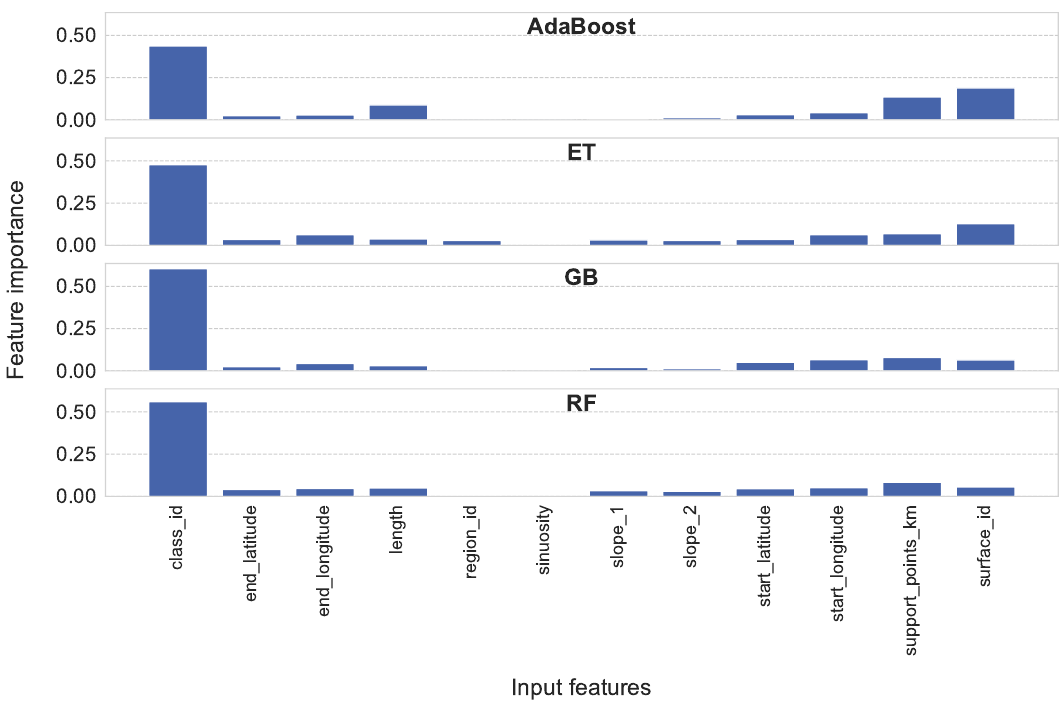
Figure 7. Feature Importance of the tree-based regressors for the combined dataset with the Basic input